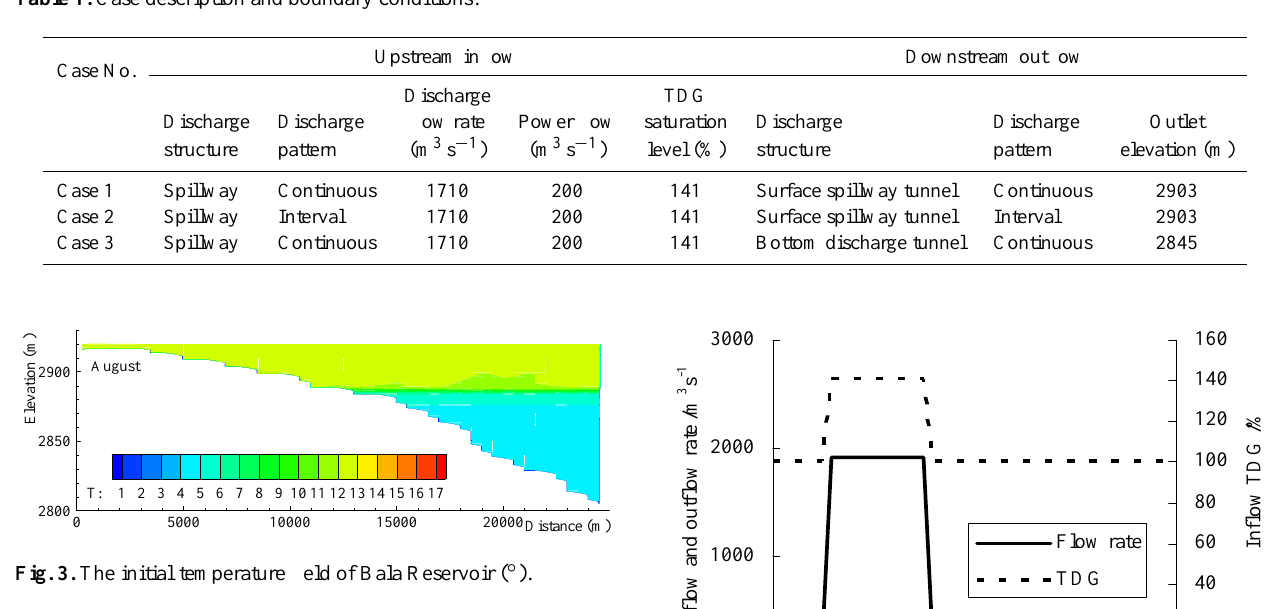
Table 1. Case description and boundary conditions.